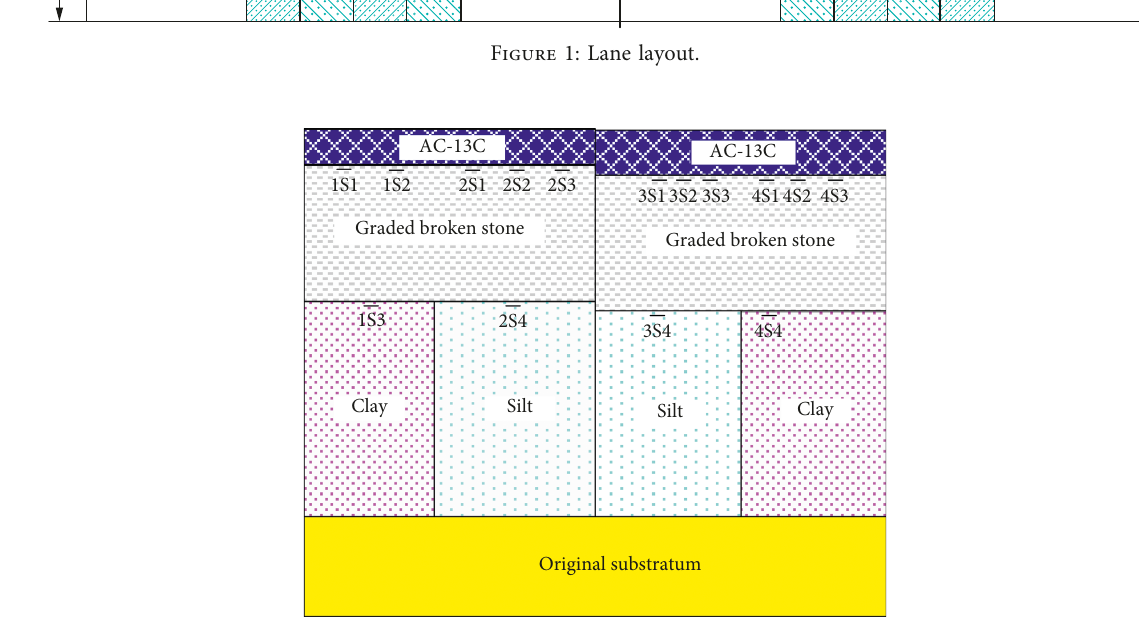
Figure 2: Structure of test lane. Table 1: Pavement structures.